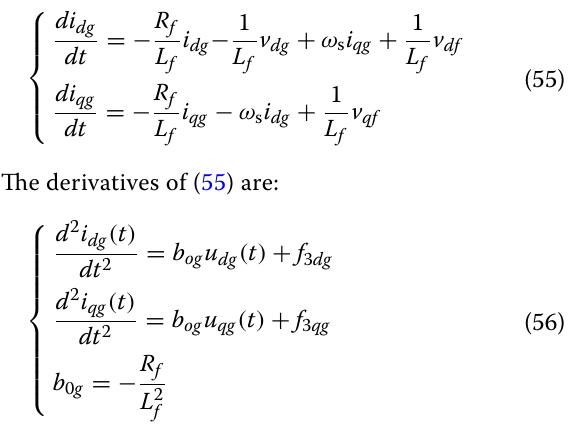
the d q frame to be used in FFOADRCs. The network − voltage angle ( θ g ) is required for conversion between the d q and α β frames. This is obtained using a − − phase locked loop (PLL). The network voltages in − the d q frame ( v dg , v qg ) were expressed in (11), so the −